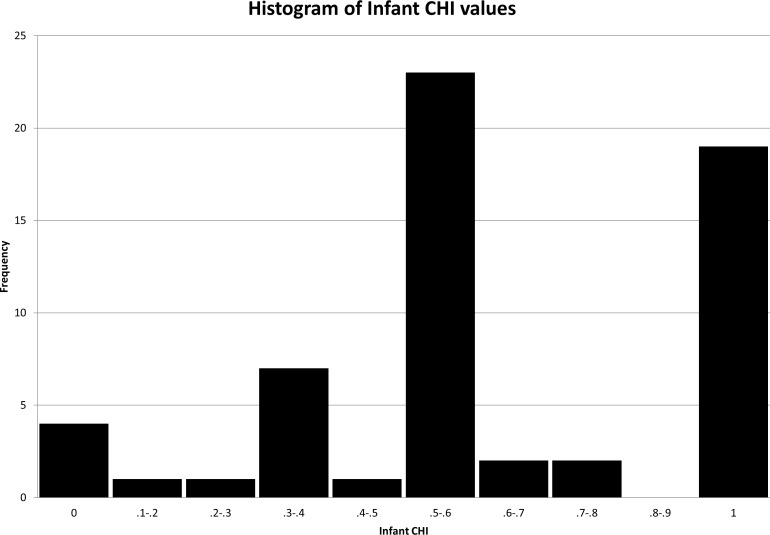
Histogram of infant CHI values.Distribution of CHIi values across chimpanzees in the study.